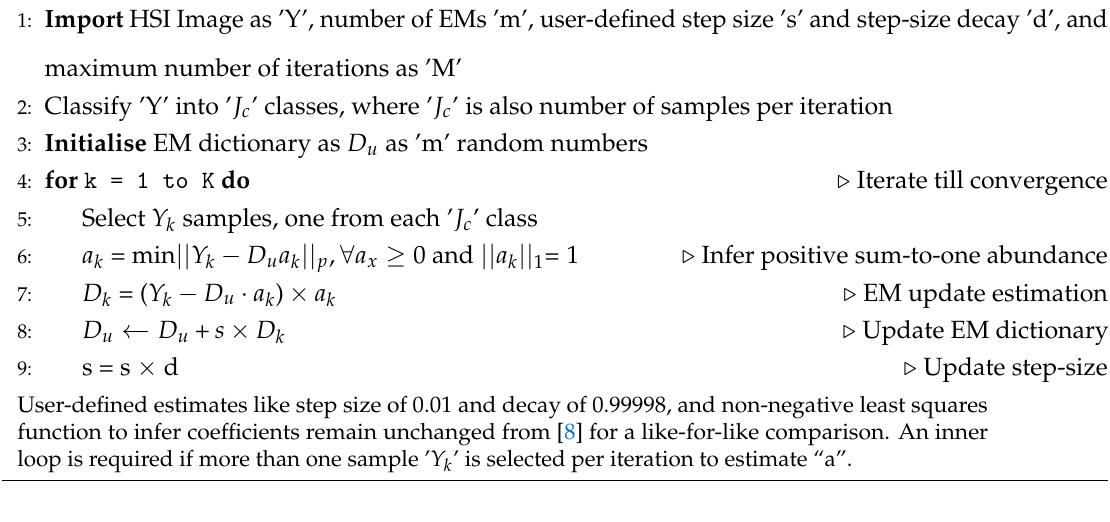
Algorithm 1 Proposed K-Means SCD (KMSCD) algorithm.